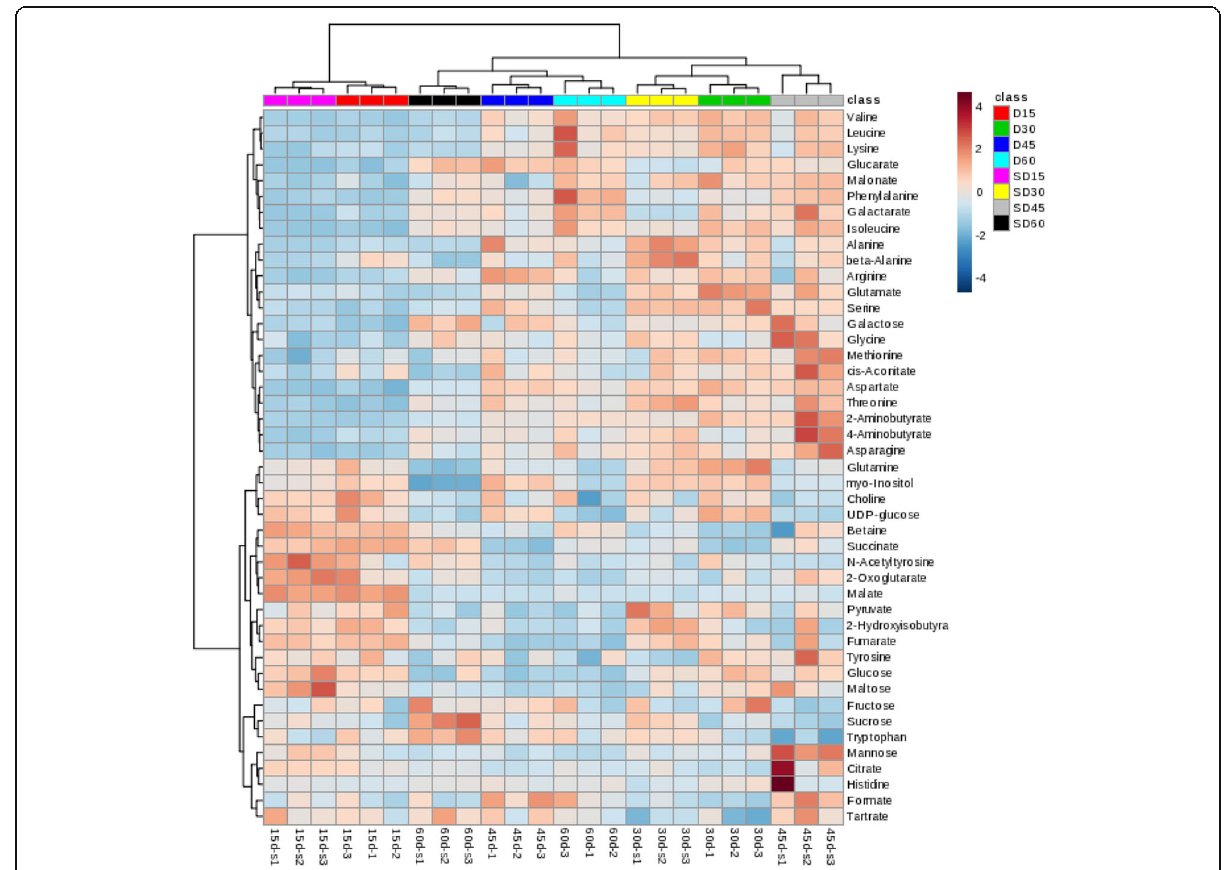
Fig. 2 Heatmap of effect of exogenous spermine on metabolite profiles of cold-stored immature vegetable soybeans. Red colour indicates higher metabolite concentration than the median of the samples, blue indicates a lower concentration. The metabolites are listed on the right side of the heat map with metabolite clustering on the left. All samples are listed on the top of the map as well as the sample clustering